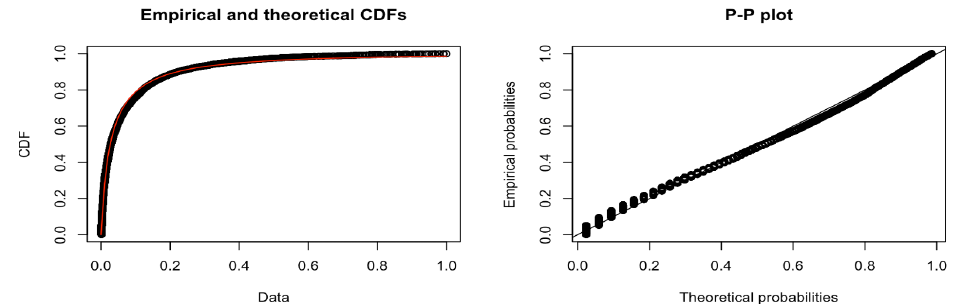
Figure 16. Batch by split count, log-normal model